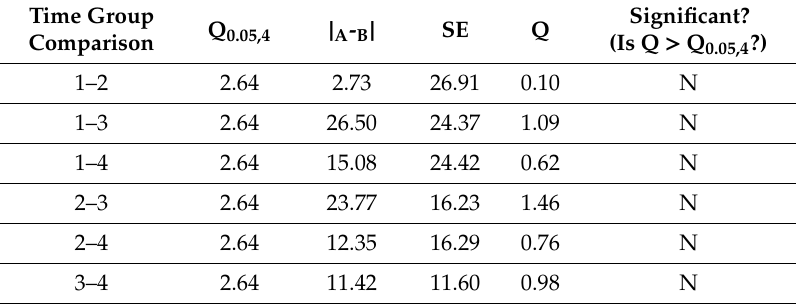
Over the 32-year study period, high-severity fire patches > 400 ha occurred on ~0.7% to ~2.7% of the total area of frequent-fire conifer forest, depending on the region, such that the rotation intervals for occurrence of large ( > 400 ha) CESF patches, created by high-severity fire, ranged from 1181 years to 4354 years (Table